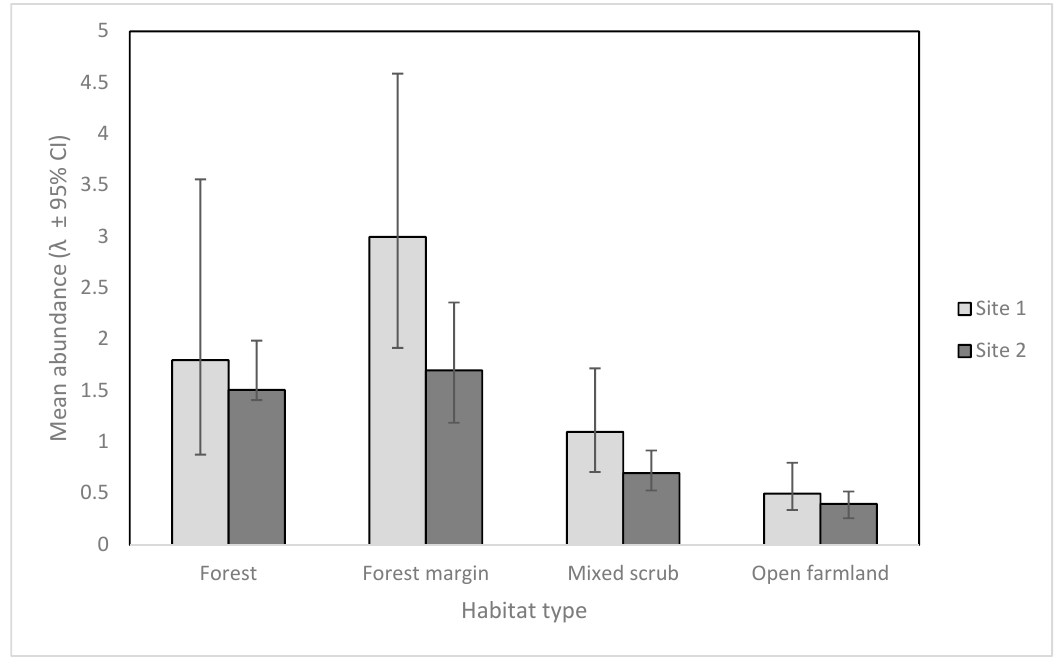
Figure 2. Mean cat abundance ( λ ) for cameras in each habitat type, (± 95% CI) at Site 1 and Site 2. Model output showed little support for the null model with cat abundance varying by habitat type as seen in Table